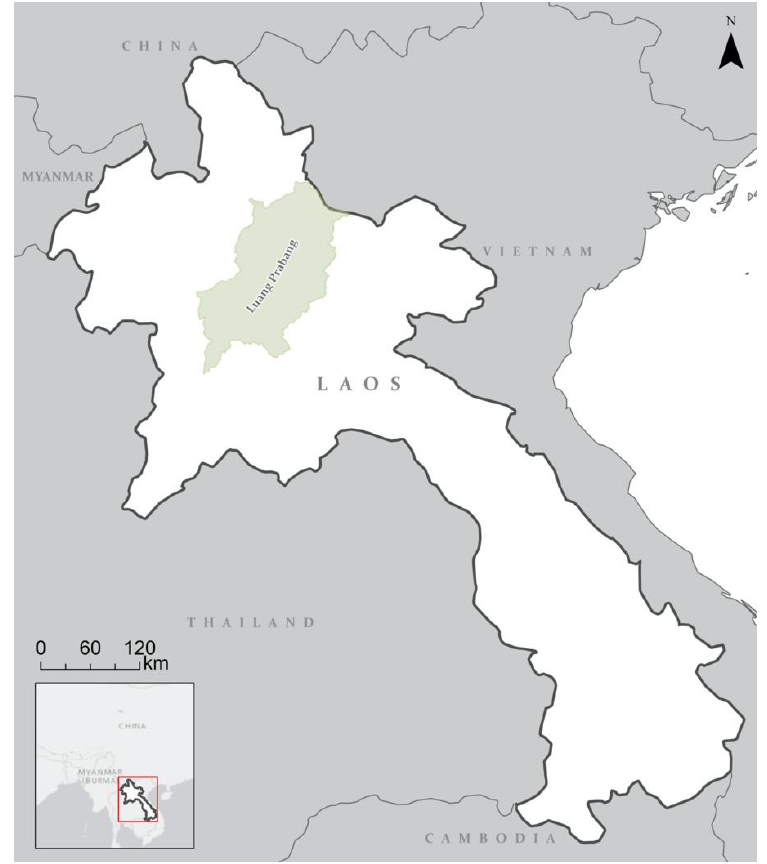
Figure 1. A map of Laos. Luang Prabang is indicated in the northeast of the country. As can be seen, Laos borders five countries: China, Myanmar, Vietnam, Cambodia, and Thailand (Map created by J. Stacey-Dawes).